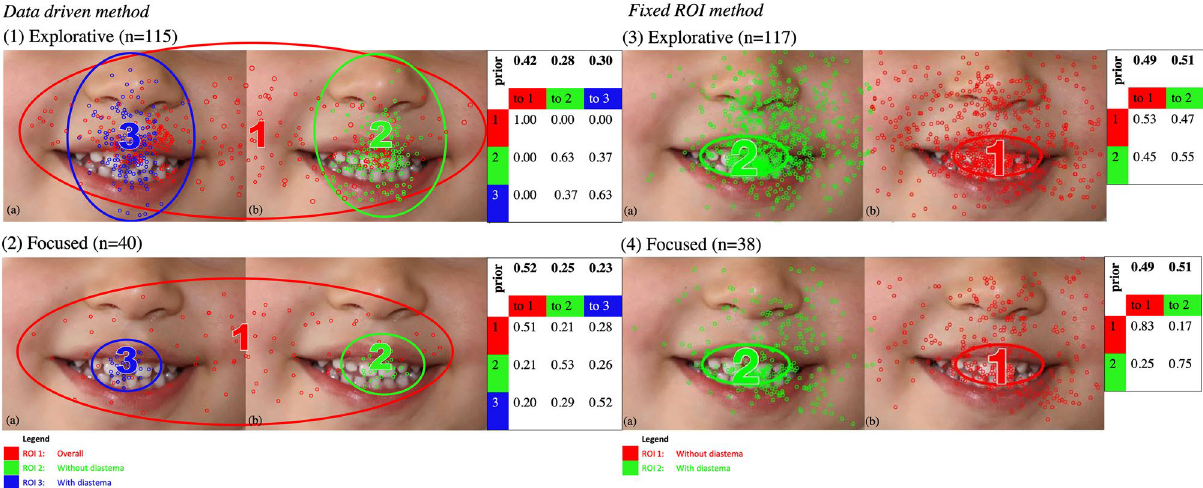
Figure 2. The two different eye movement patterns were identified in children using the data-driven and fixed ROI methods. Children data-driven method: (1) explorative pattern, where children’s ROIs were predominantly around the nose and mouth, and (2) focused pattern, where children’s ROIs were mainly on the teeth, i.e. images with and without a diastema. Ellipses show two standard deviation contours from the mean of the ROIs (2D Gaussian distributions). Small circles in different colours show the assignment of raw fixations to different ROIs. The table shows transition probabilities among the ROIs. Priors show the probabilities that a fixation sequence starts from an ROI. For example, children in the explorative pattern showed a 42% chance of the first fixation in ROI1, 28% chance in ROI2, and 30% in ROI3. After that, they remained in the same ROI (ROI1 = 100%, ROI2 = 63%, ROI3 = 63%) or switched ROI (ROI2 to ROI3 = 37% and ROI3 to ROI2 = 37%). Children fixed ROI method: (3) explorative pattern, where children tended to switch between the two images more often and (4) focused pattern, where children looked at the same image for a while before switching to the other image. The ROIs are defined as elliptical areas in the mouth region and represented as ROI1: without diastema and ROI2: with diastema. Note: small circles show raw fixation locations, and the colour of the small circles indicate ROI assignments. Priors indicate the probability that a fixation sequence starts from the corresponding ROI.